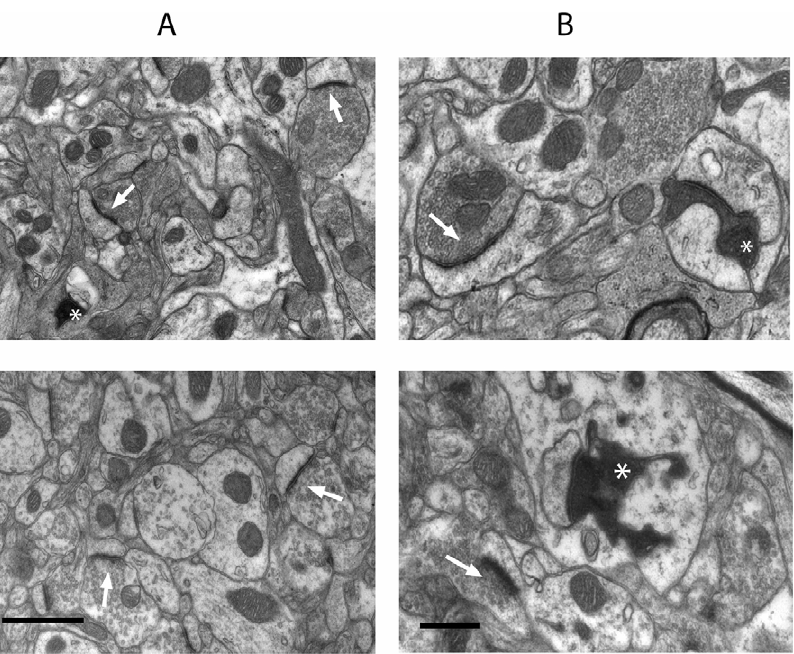
Figure 5. Synaptic protection in the striatum remains robust in old ( , 12 month old) homozygous Wld S mice after cortical lesion. Representative electron micrographs of striatal synapses at low power (A) and higher power (B) from an old wild-type mouse (top panel) and old homozygous Wld S mouse (bottom panel) 3 days after cortical lesion. Asterisks indicate degenerating synaptic profiles (identified principally by their electron dense cytoplasm) and arrows indicate healthy (i.e. non-degenerating) synaptic profiles. Degenerating synapses were readily identified in wild-type mice but rarely observed in homozygous Wld S mice. As in young mice (see Figure 2), the morphological appearance of degenerating synapses was indistinguishable between the different genotypes. Scale bars; A=1 m m, B=0.5 m